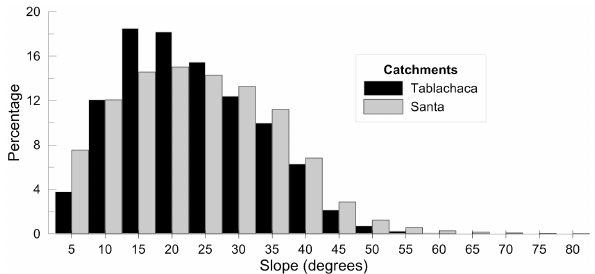
Fig. 8. Histogram of the normalised percentage distribution of slopes generated from the 90m-resolution digital elevation model (DEM) in the Santa and Tablachaca study catchments.